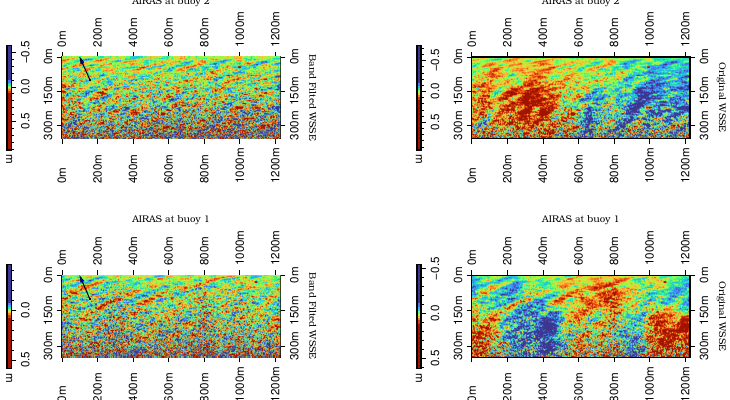
Figure 5. The relative sea surface elevation measured by the AIRAS. The right-hand panels show the unfiltered AIRAS data; the left-hand panels show the band-pass filtered AIRAS data (3–150 m). The arrows in the left-hand images represent the direction of wave propagation. The X-axis is the direction of AIRAS flight and the Y-axis is the cross-track